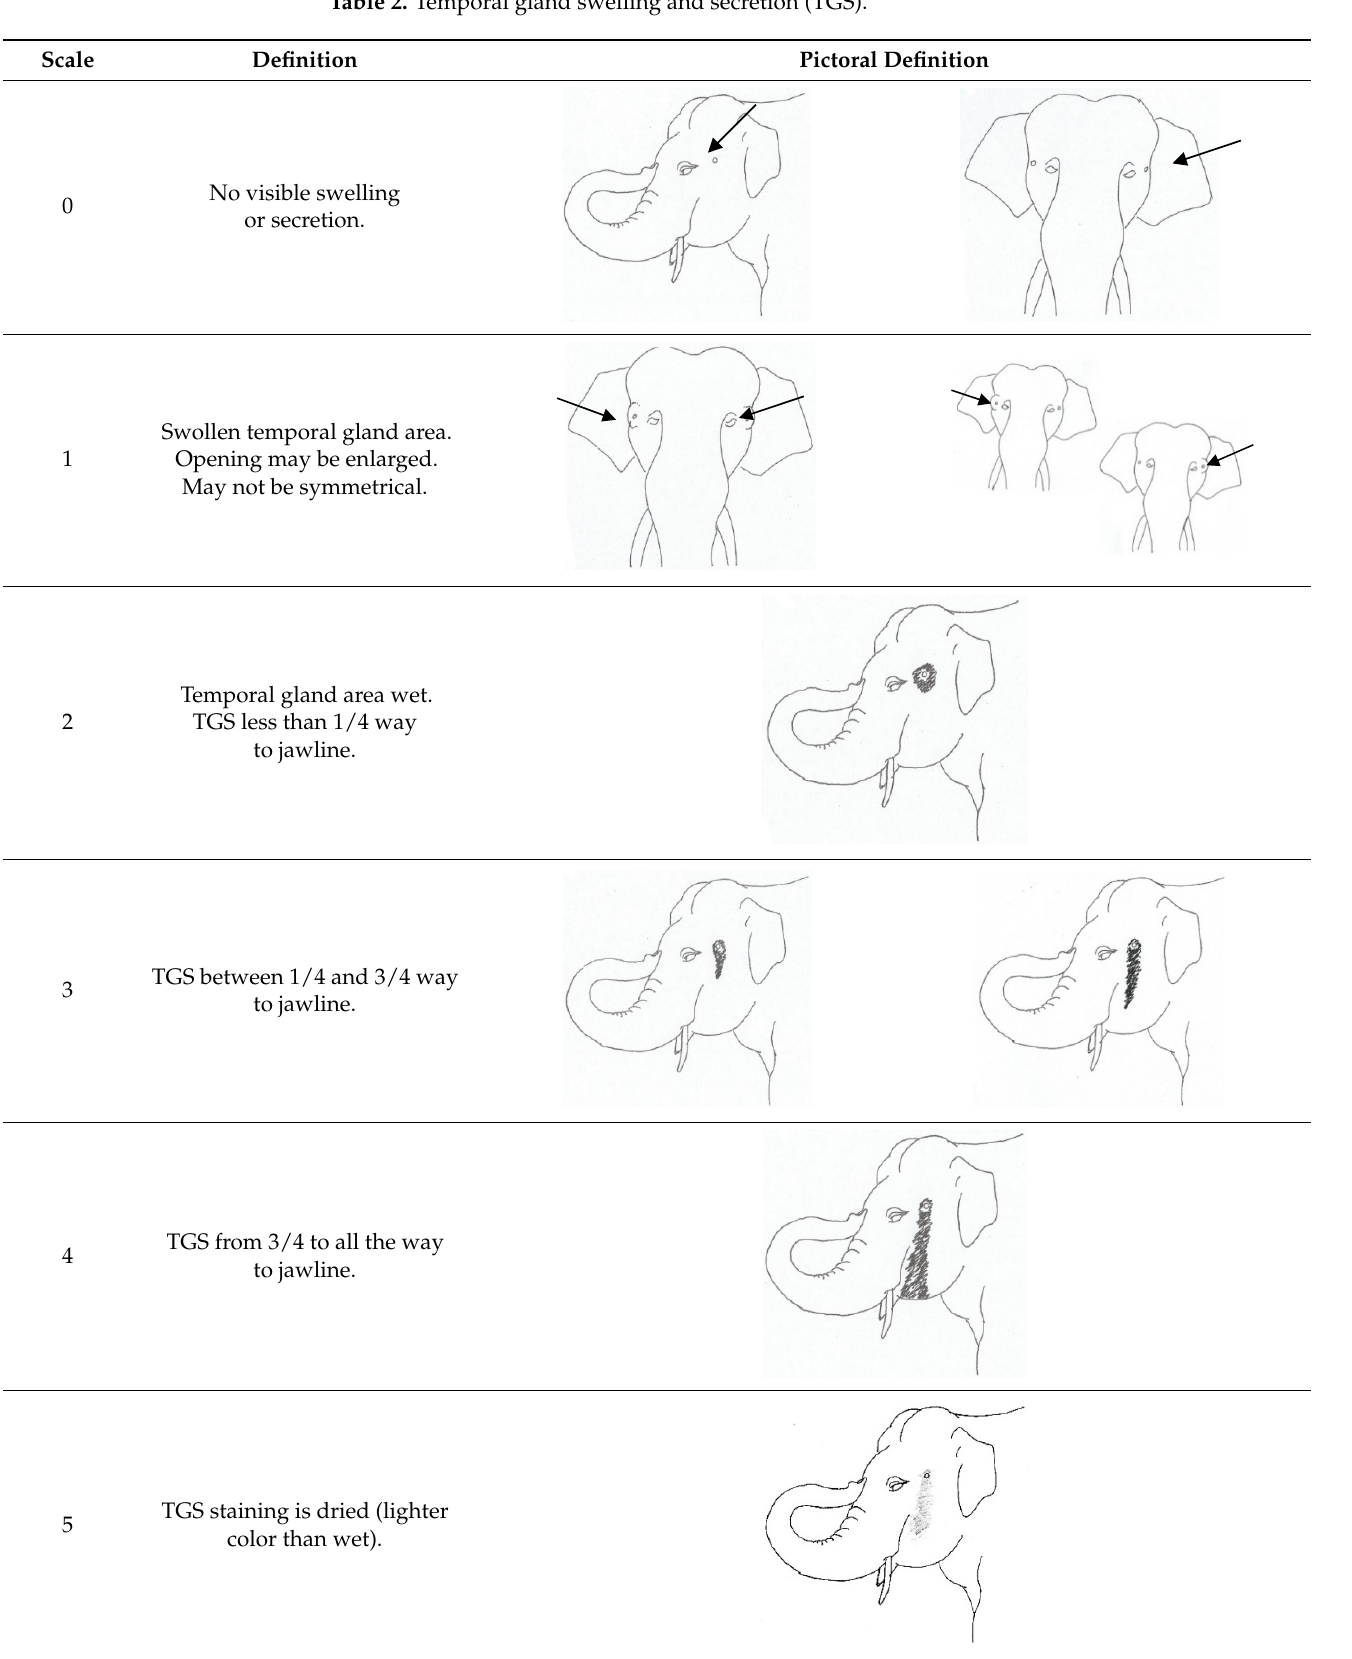
Table 3. Temporal gland swelling and secretion (TGS).